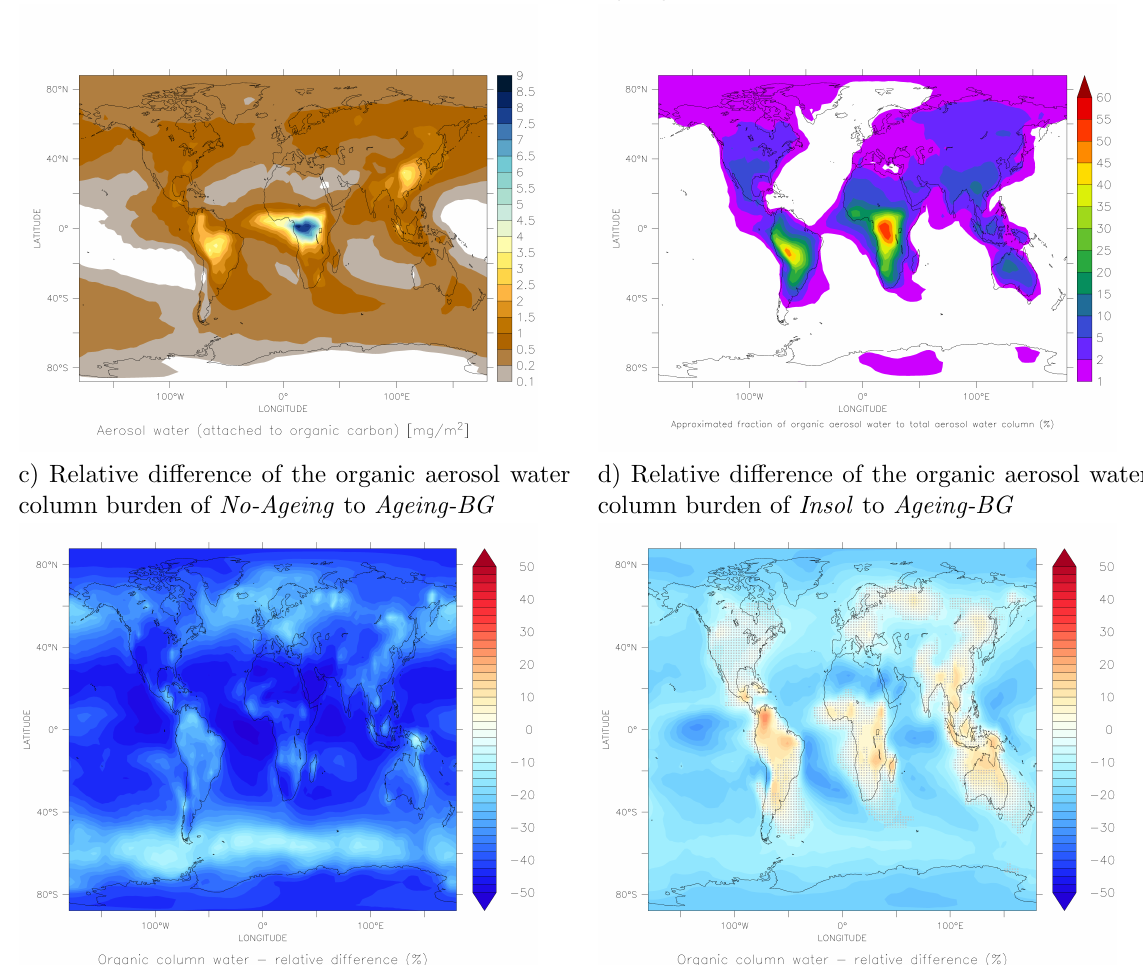
Fig. 6. Annual averages of the organic aerosol water column burden (in mgm − 2 ) for the Ageing-BG simulation (panel a ). Note the logarithmic scale. (b) shows the relative contribution (in %) to the total aerosol water column burden for the respective column. Also note the irregular color scale. (c) and (d) display the relative differences of the No-Ageing and Insol simulations to the Ageing-BG scenario in %; dotted areas mark regions of low statistical